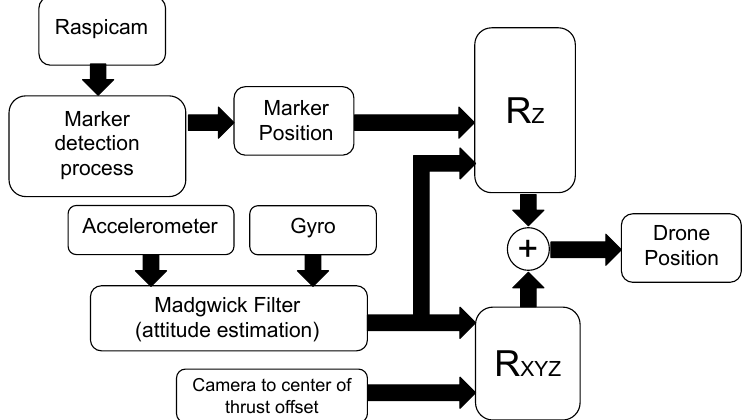
Figure 10. Schematic representation of the algorithm “Stabilized Camera Frame Madgwick Filter 2DOF“ (SCF-MF-2DOF). Differently to previous methods, the 2-DOF gimbal suspension is used to stabilize the video stream data with respect to the pitch and roll angles of the attitude vector. As a result, the marker coordinates have to be corrected by means of a rotation just along the z -axis of the estimated attitude yaw angle (cid:98) ψ . This stabilization procedure has the advantage to reduce the noise in the video stream and thus improve the accuracy of position